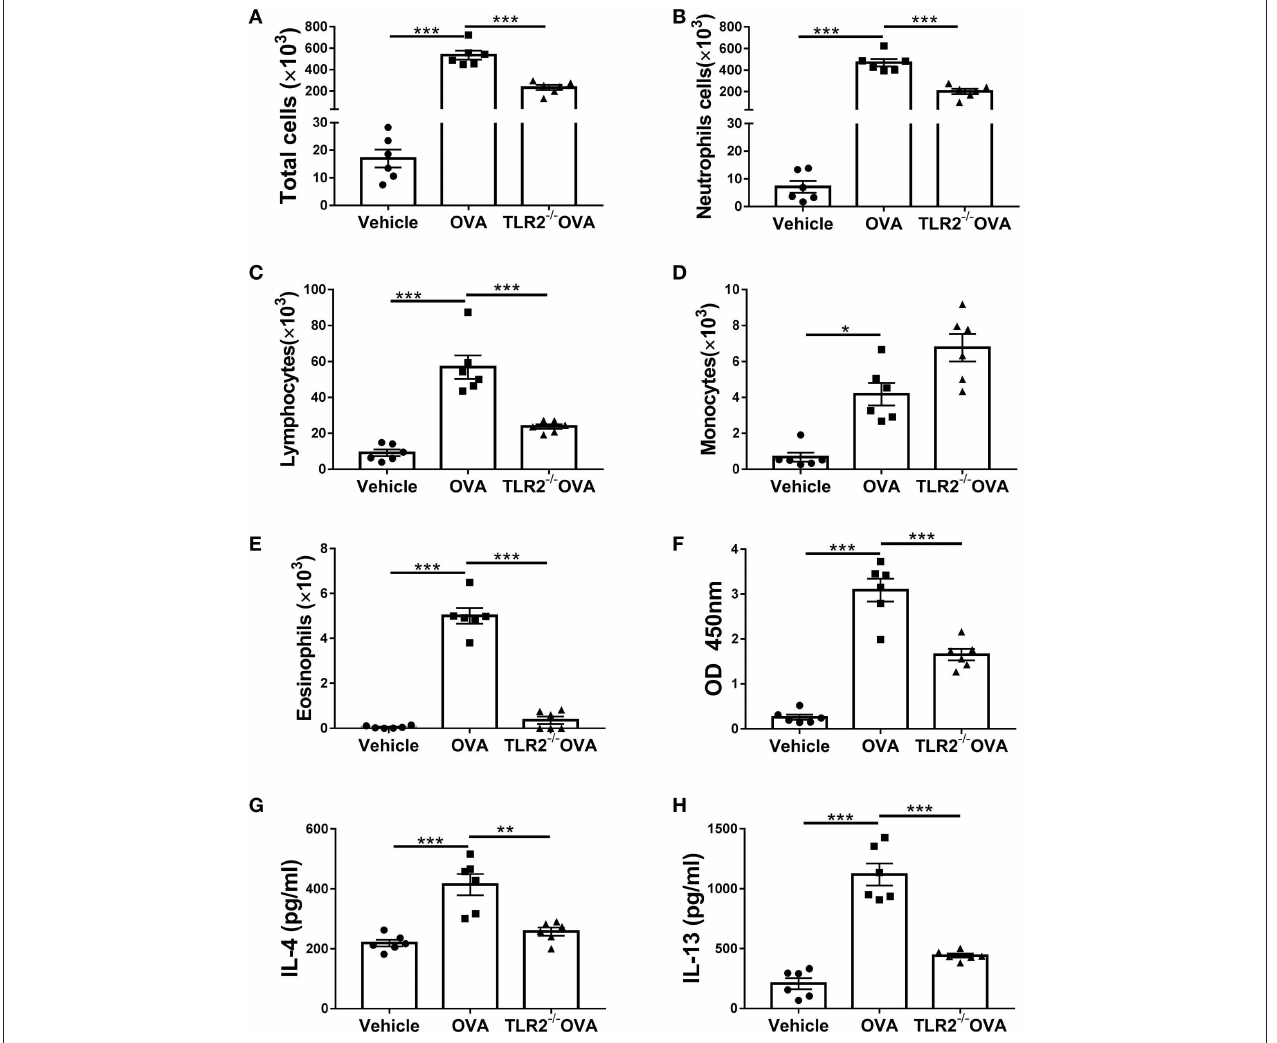
FIGURE 2 | TLR2 is required for OVA-induced inflammatory cells infiltration, IgE and Th2 cytokines production. (A) Total cell counts in the BALF of WT and TLR2 − / − mice. (B–E) Differential cell counts in BALF of WT and TLR2 − / − mice. (F) The level of OVA-specific IgE in serum. (G,H) Productions of IL-4 and IL-13 in BALF of WT and TLR2 − / − mice were analyzed by ELISA. * p < 0.05, ** p < 0.01, *** p <